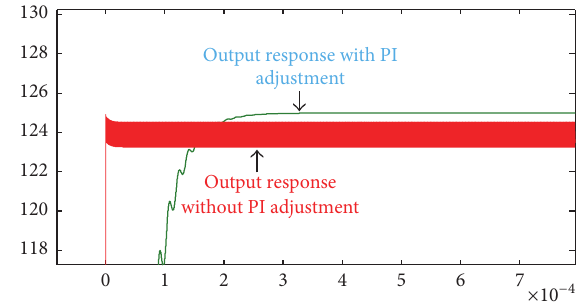
Figure 6: Step response simulation waveforms.